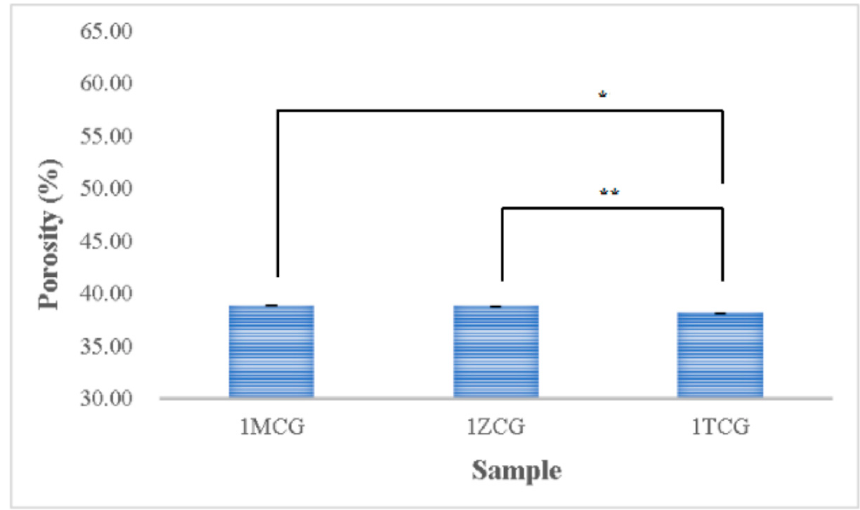
Figure 5. Porosity of CS/gel/mineral porous gel as related to the mineral type (* p < 0.05, ** p < 0.01).